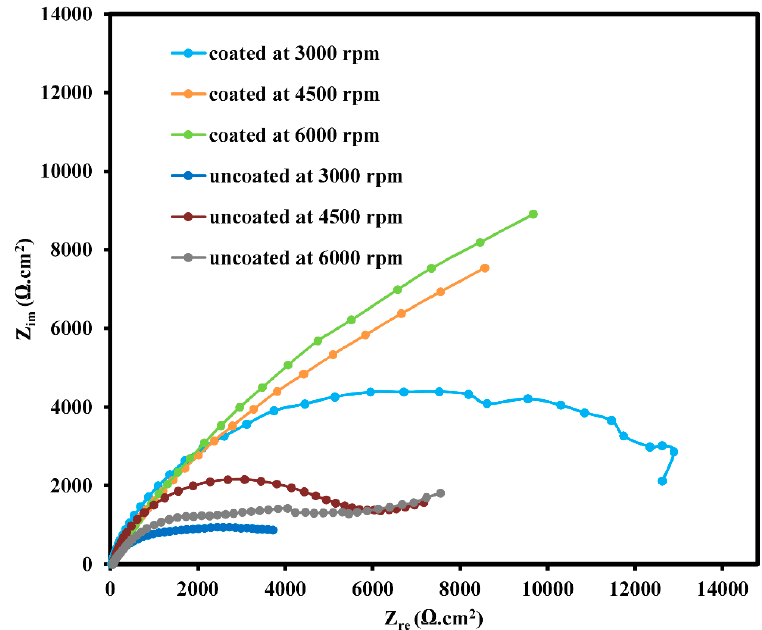
Figure 7. Bode phase plots for the Cr 3 C 2 –NiCr ‐ coated and uncoated SS316 samples at different rotation speeds.